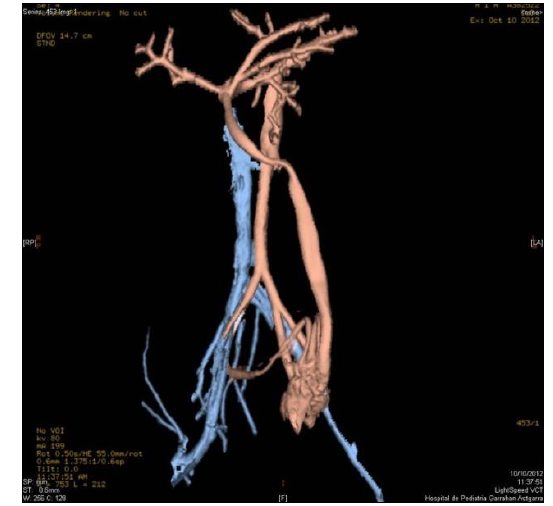
Figure 4: Umbilical AVM with inflow from the umbilical arteries and outflow via the umbilical